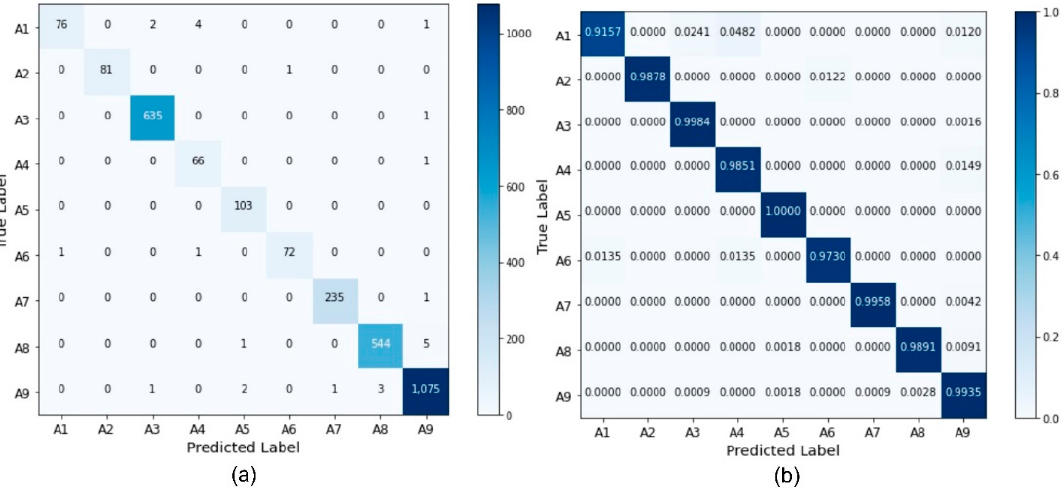
Figure 11. Confusion matrix: ( a ) unnormalized; ( b ) normalized.